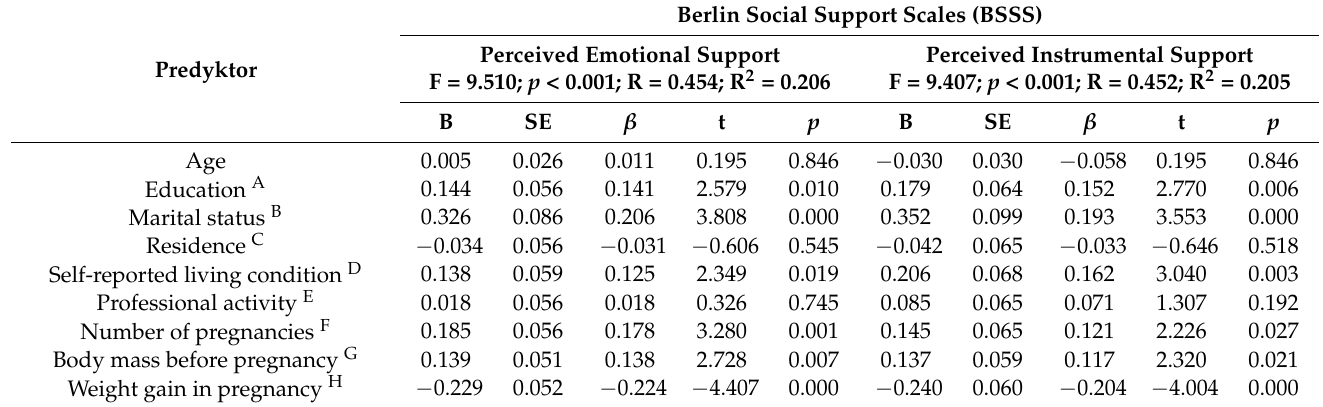
Table 6. Regression analysis of perceived social support and sociodemographic variables.